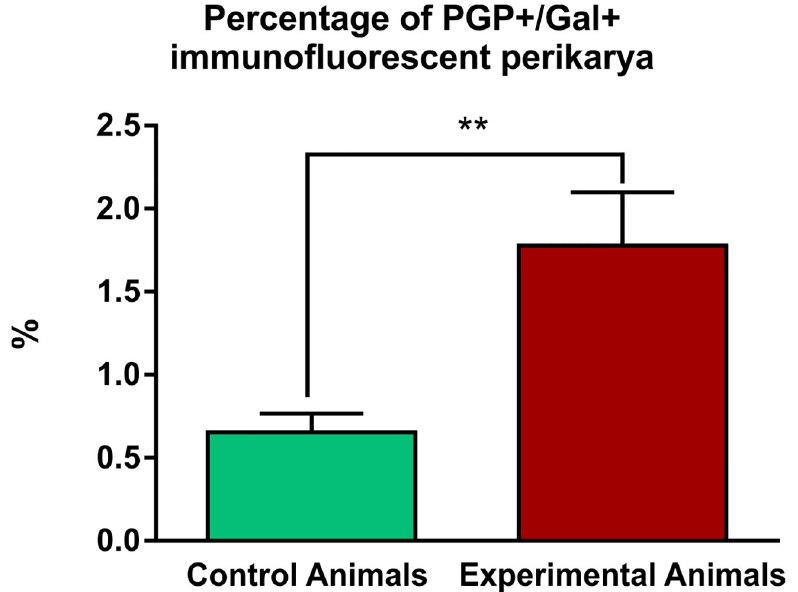
Fig 4. Percentage differences in the nodose vagal ganglia PGP 9.5/Gal-immunofluorescent perikarya between control and experimental animals. Graph showing the percentage of PGP/Gal-immunofluorescent perikarya observed in the nodose vagal ganglia in the control and experimental animals. The increase was statistically significant ( �� p < 0.005; error bars indicate SEM).